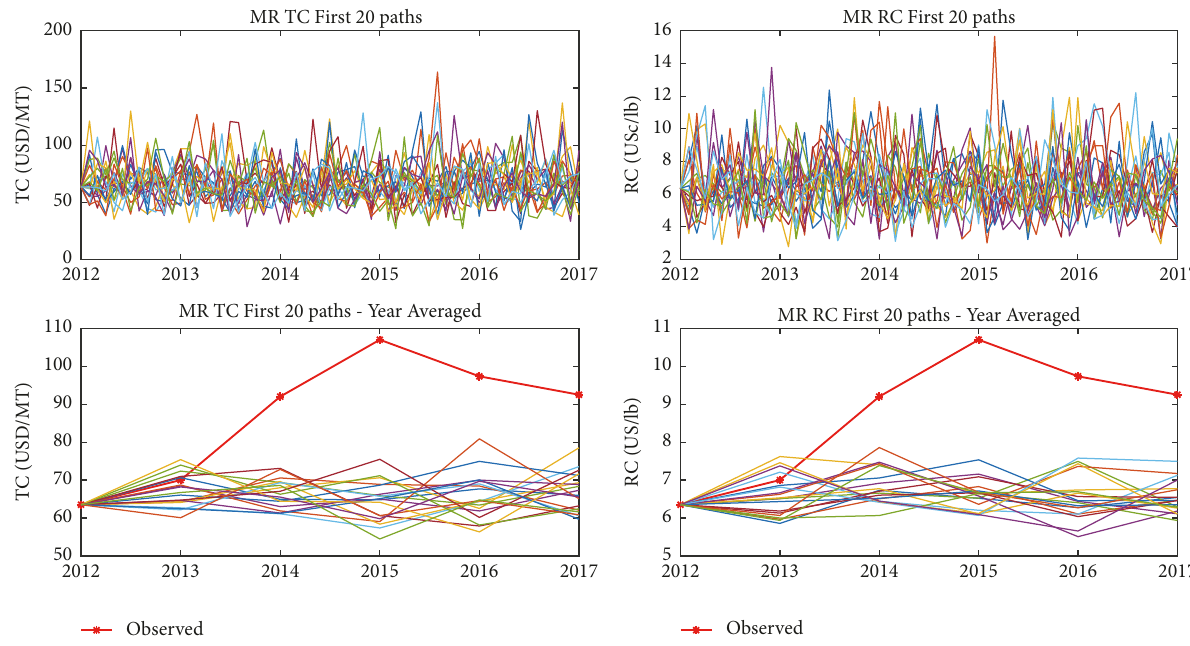
Figure 3: The first 20 Monte Carlo paths following the OUP model using monthly steps are shown on the upper illustrations for either TC or RC. The annual averaged simulated paths every 12 values are shown